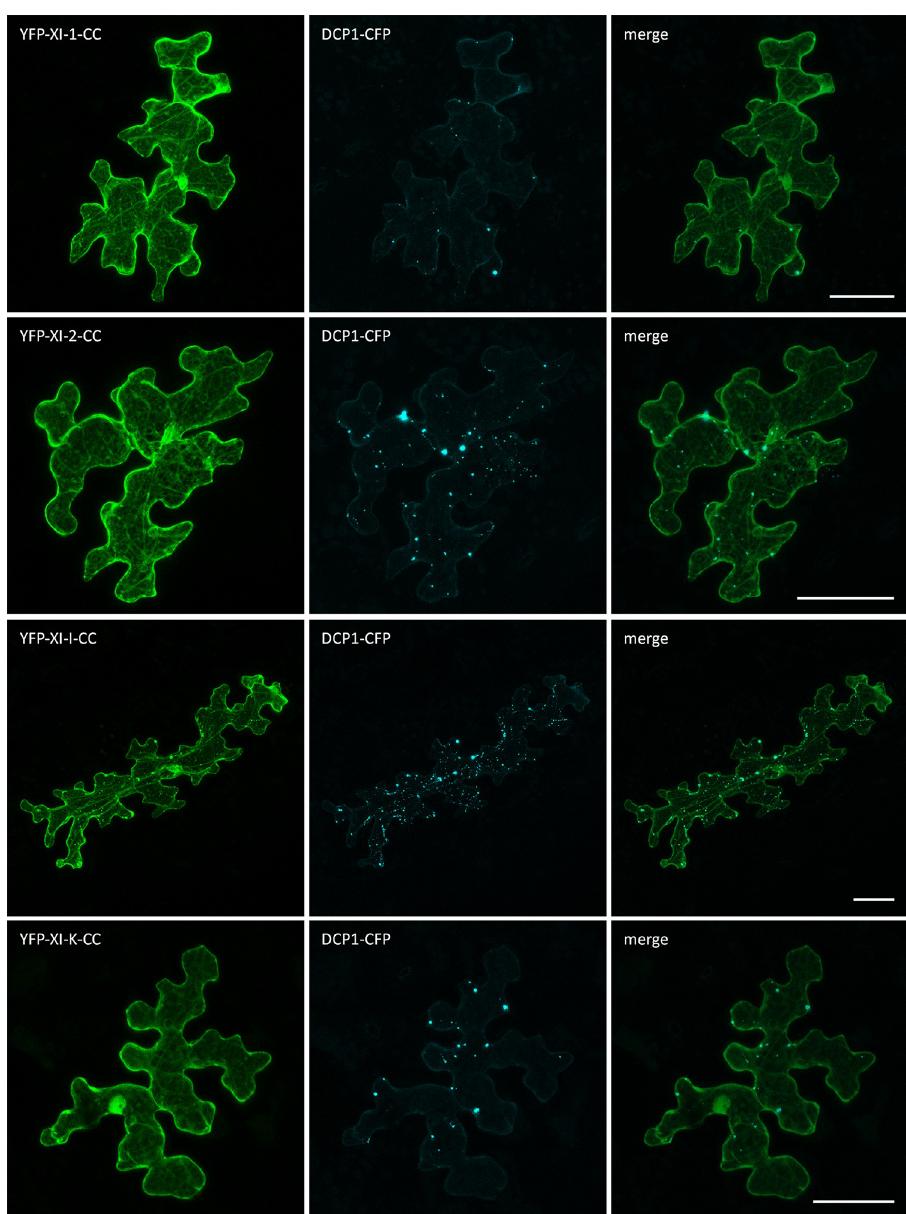
Fig 6. Co-localization of myosin coiled-coils and DCP1 in Arabidopsis epidermal cells. Transient expression of DCP1-CFP with myosin coiled-coils in Col-0 epidermal pavement cells. The scales display 50 μ m.